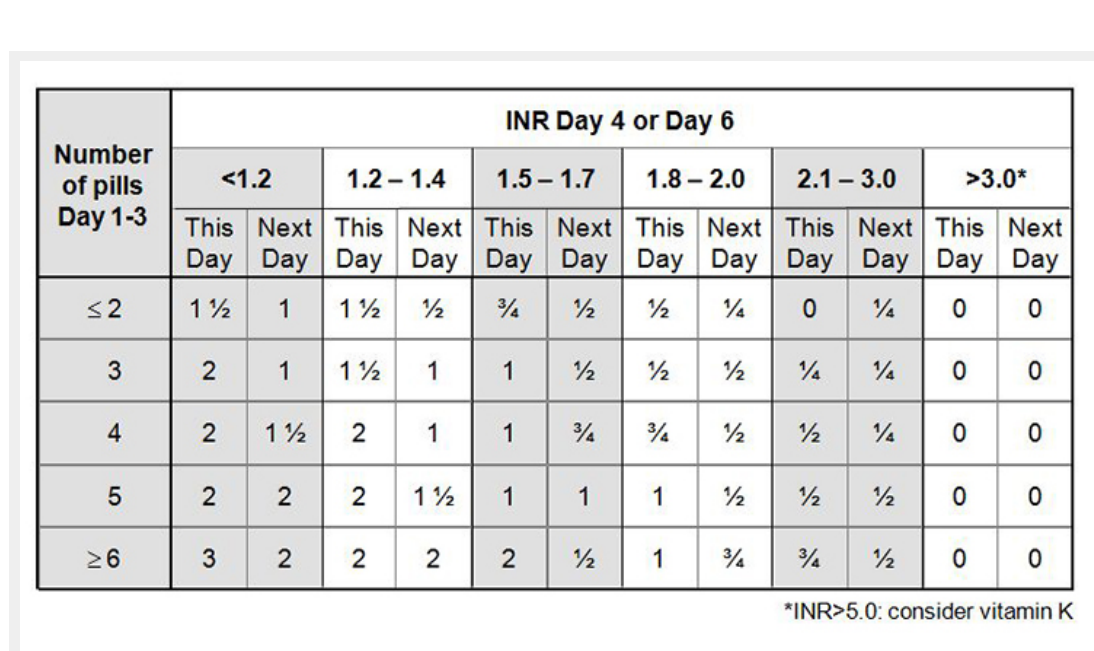
Figure 5 Revised dosing algorithm for days 4 and